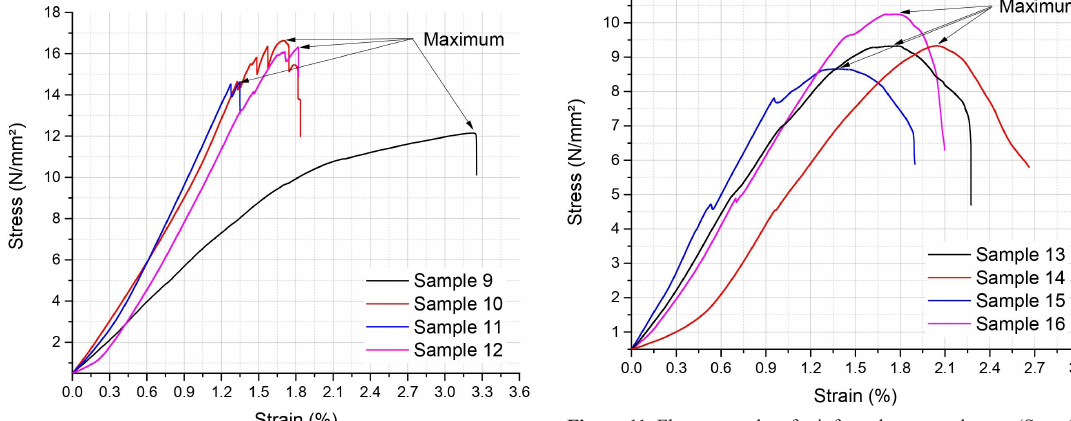
Figure 11. Flexure results of reinforced concrete beams (Samples 13 to